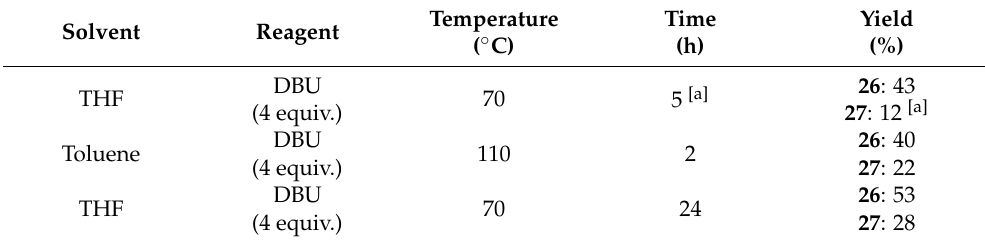
Table 1. Optimization of the DBU mediated elimination reaction of 25